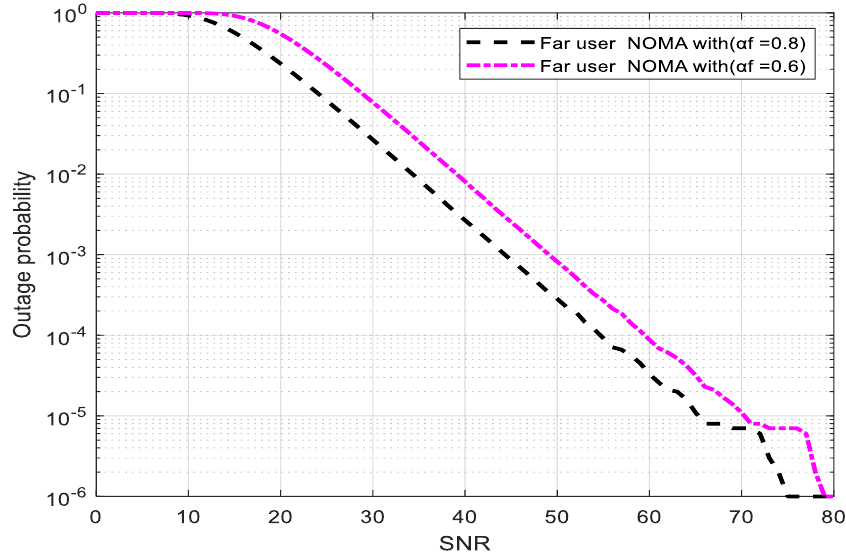
Figure 6. Outage probability against SNR for the two far users ’ DL NOMA PD.